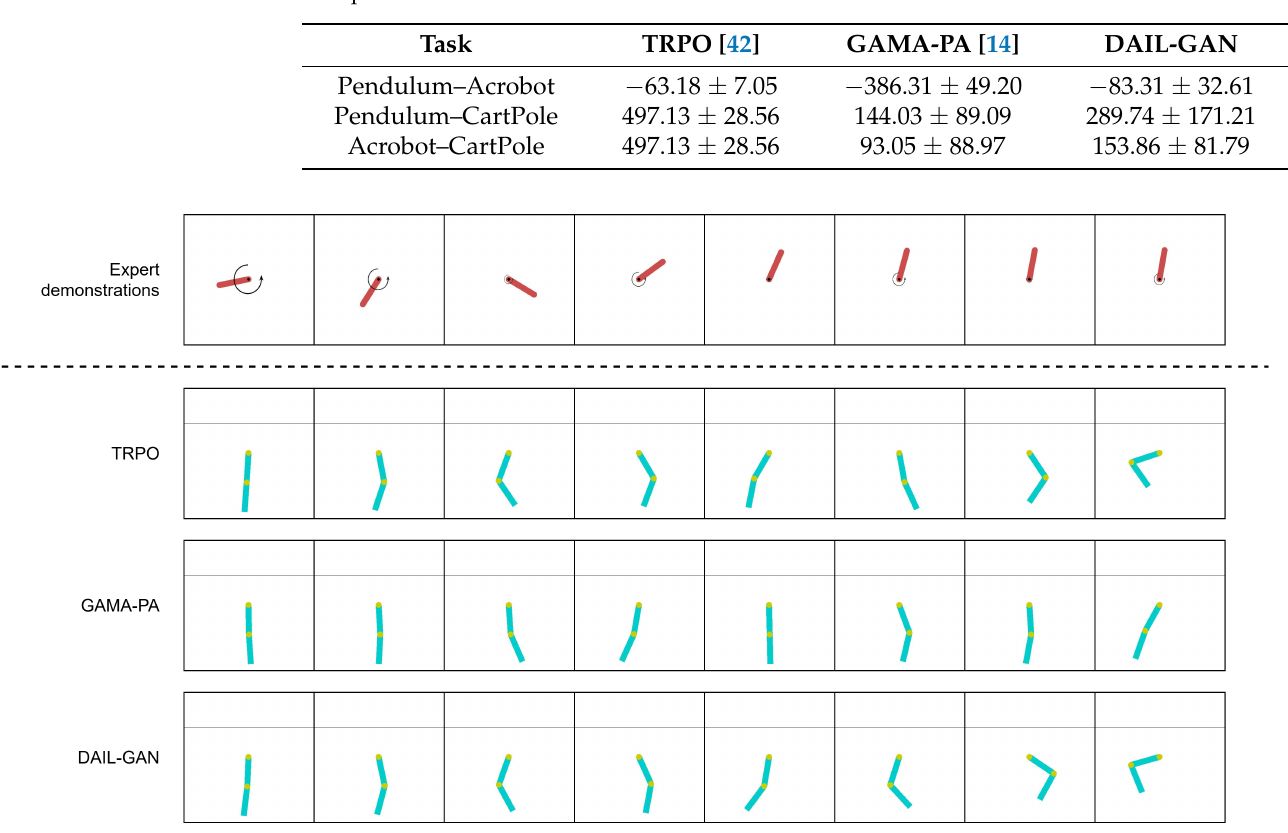
Table 3. The performance of the proposed models on low-dimensional tasks. These scores represent the cumulative rewards obtained from executing a learned policy in the simulator, averaged over 100 episodes.